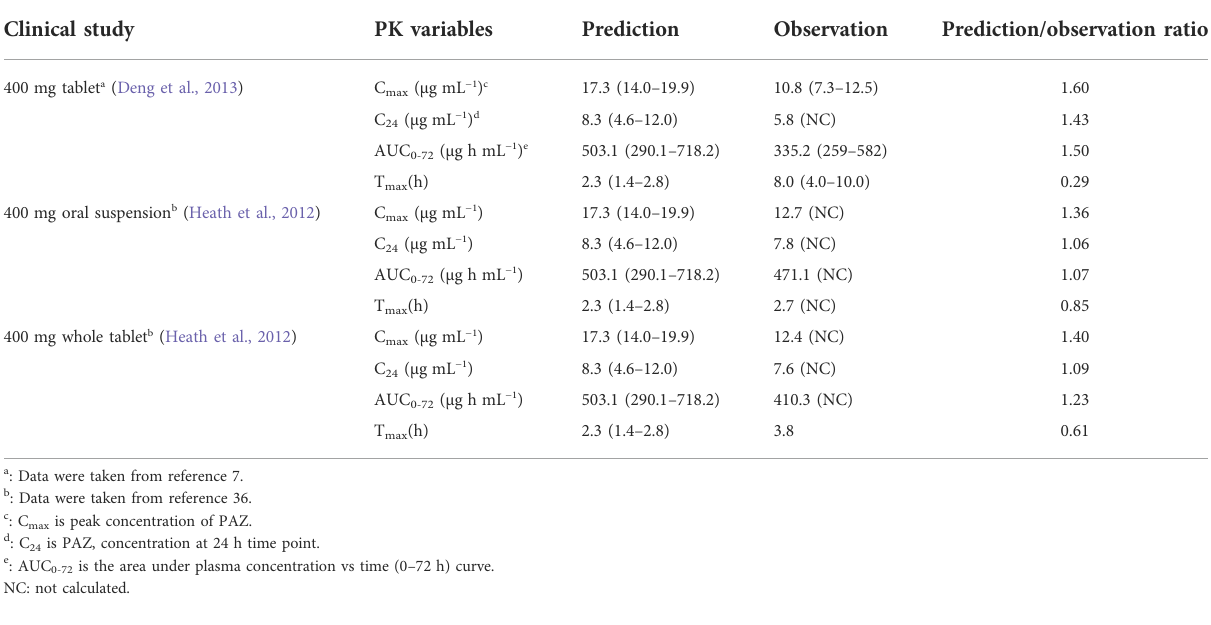
TABLE 4 Comparisons of PK variables (arithmetic mean, range) between predicted and observed data.